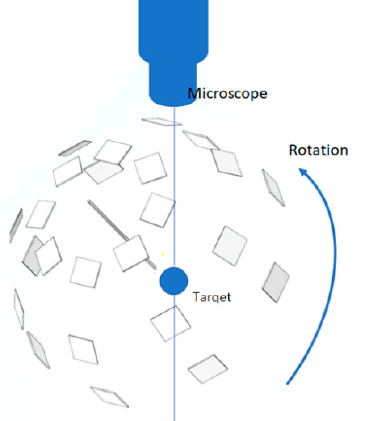
Figure 4. Capturing sequence for SfM in